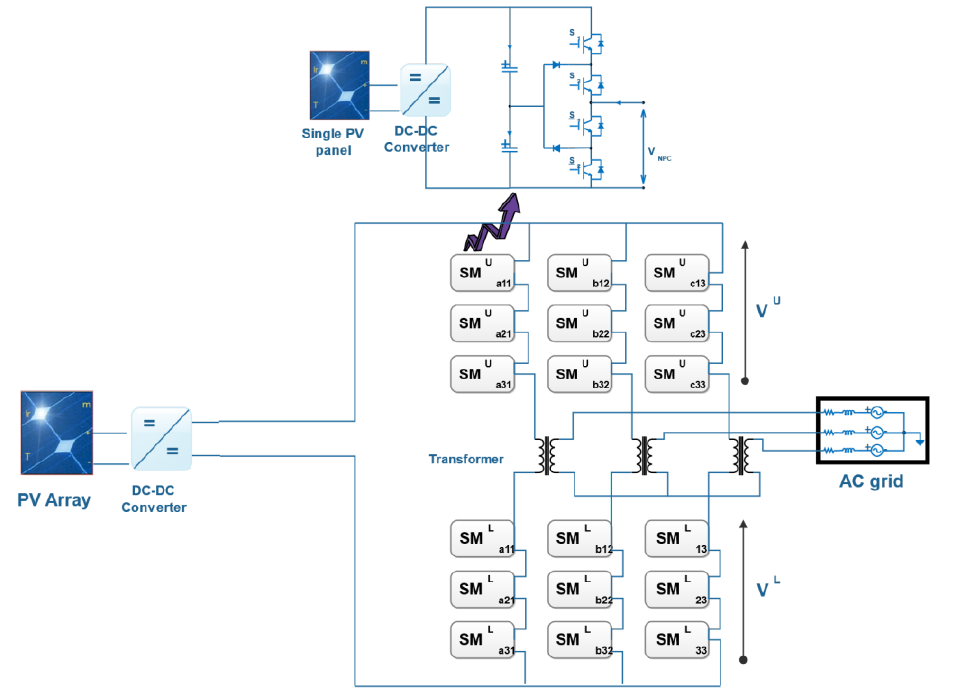
Figure 6. Schematic of the proposed modular multilevel converter.